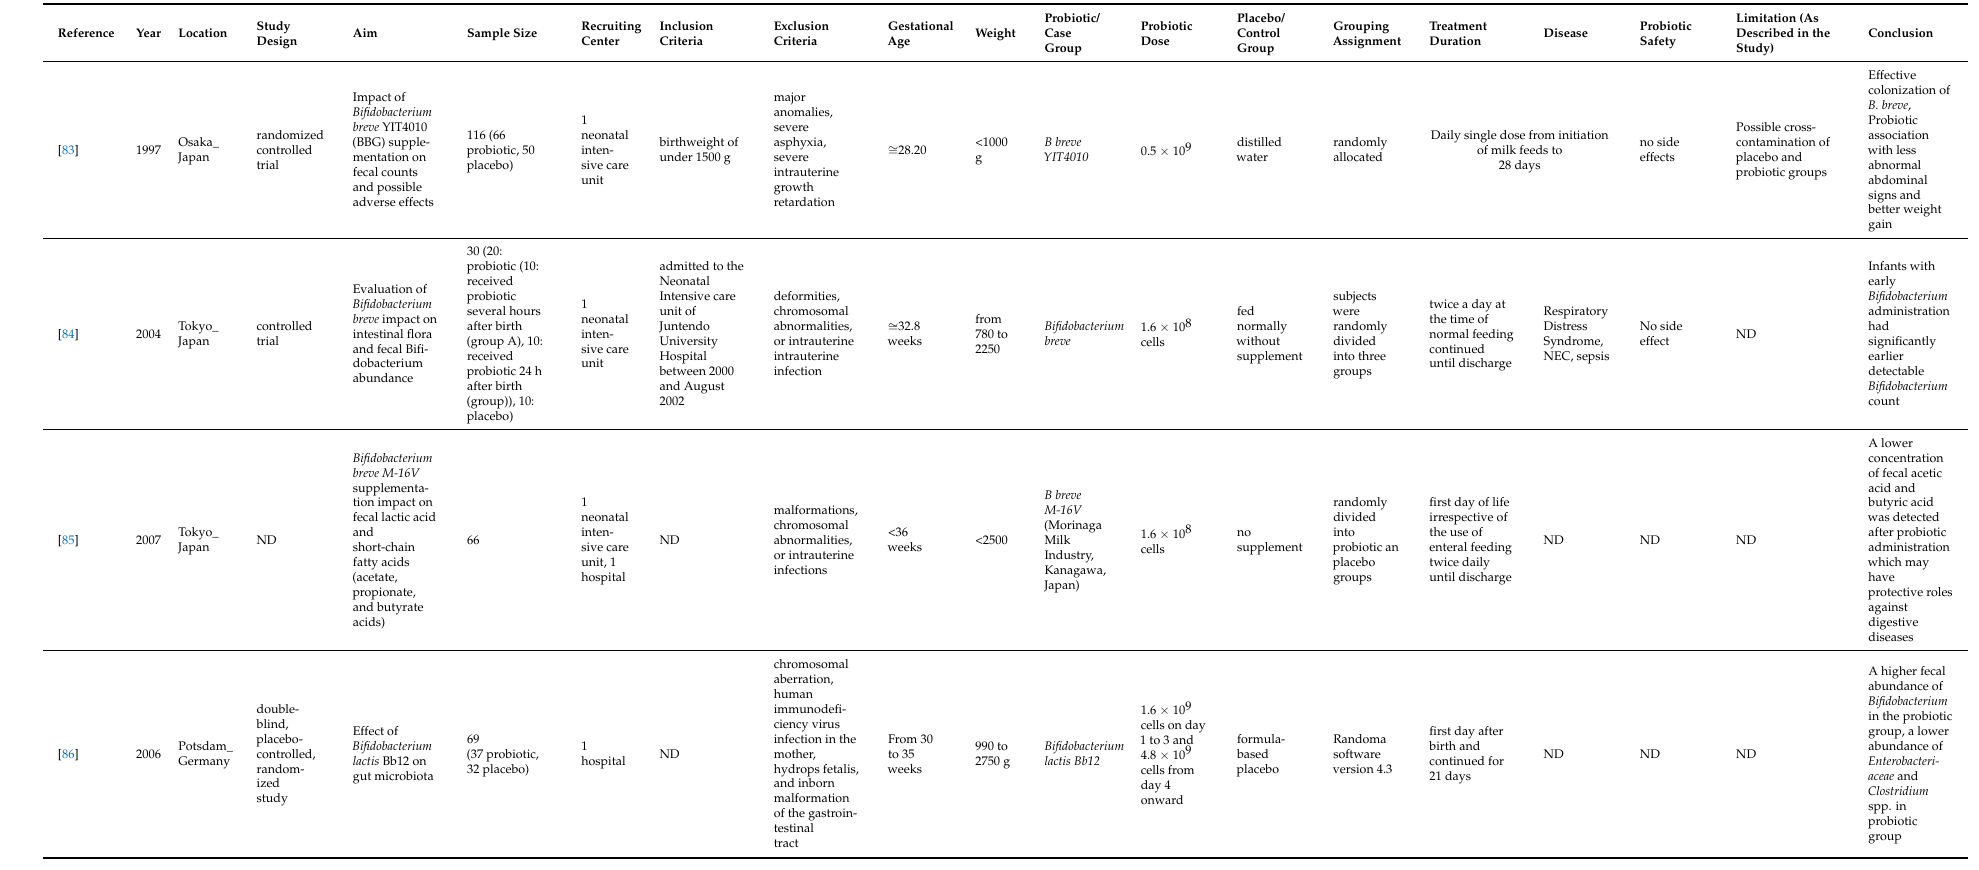
Table 1. Clinical trials on the effects of Bifidobacterium strains in preterm